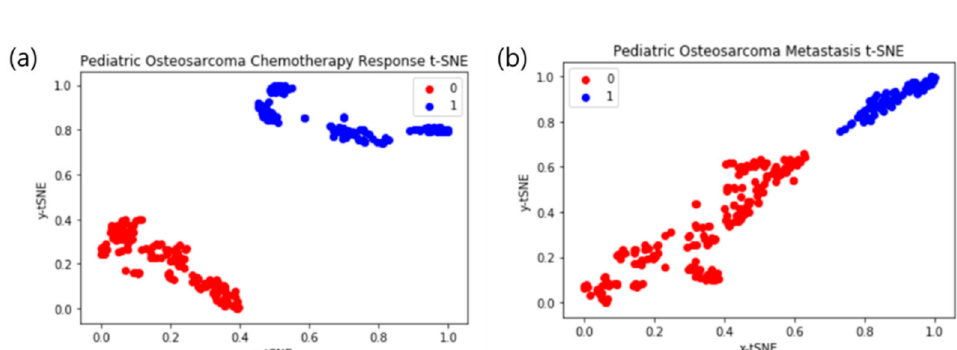
Figure 4. Deep learning t-distributed stochastic neighbor embedding (t-SNE) results. The 0/1 values represent non-responders and respondents, respectively. ( a ) Chemotherapy response t-SNE; ( b ) metastasis